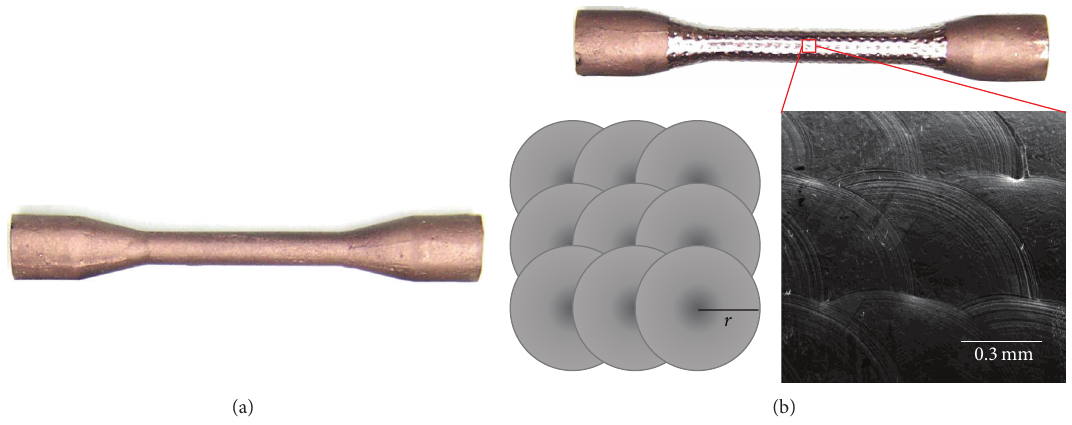
Figure 2: Schematic illustration of overlapped laser surface treatment: (a) control specimen after air-abrasion with 50 𝜇 m Al 2 O 3 and (b) laser-treated specimen; schematic illustration (bottom left, 𝑟 : radius of spot diameter) and SEM image (bottom right) of a specimen surface after laser treatment.